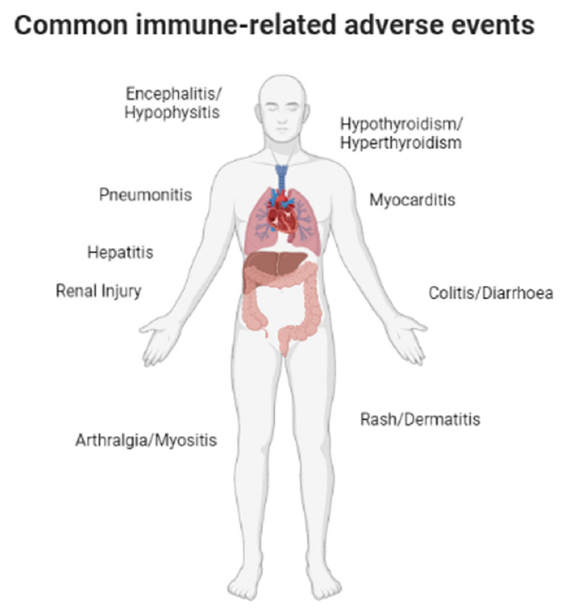
Figure 1. The commonest immune ‐ related adverse